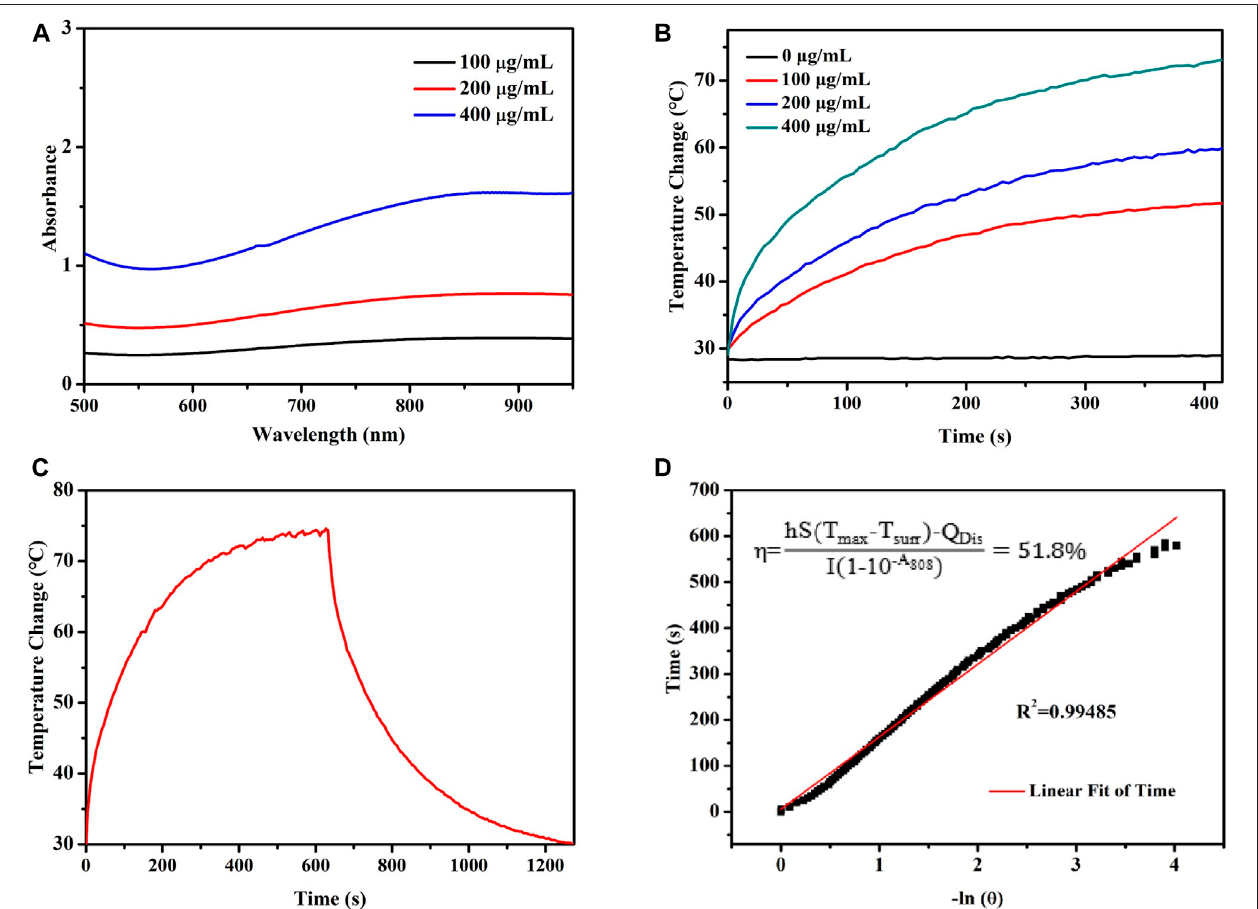
FIGURE2| EvaluationofthephotothermalpropertiesofthePPy@Fe 3 O 4 NPs. (A) UV-Vis-NIRabsorptionspectraofPPy@Fe 3 O 4 NPs. (B) Temperaturechangesof PPy@Fe 3 O 4 NCsatvaryingconcentrationsfor5 minwithlaserirradiation. (C) ThecurvesoftemperatureincreasewithirradiationandnaturecoolingforPPy@Fe 3 O 4 NCs solution (400 μ g/ml). (D) Linear regression with a system time constant of the cooling curve shown in (C) .